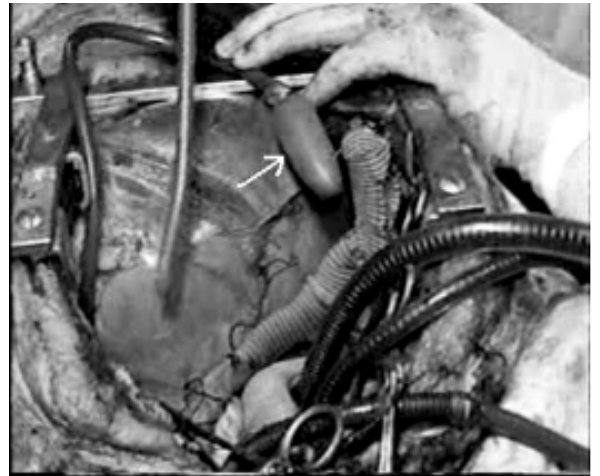
Fig. 2 - Um material elástico (parecido com balão), cujo diâmetro pode mudar de acordo com a pressão, foi fixado à porção final da cânula venosa nº 28. Quando esta cânula foi inserida através do ápice do ventrículo esquerdo, o balão inflava a cada sístole.